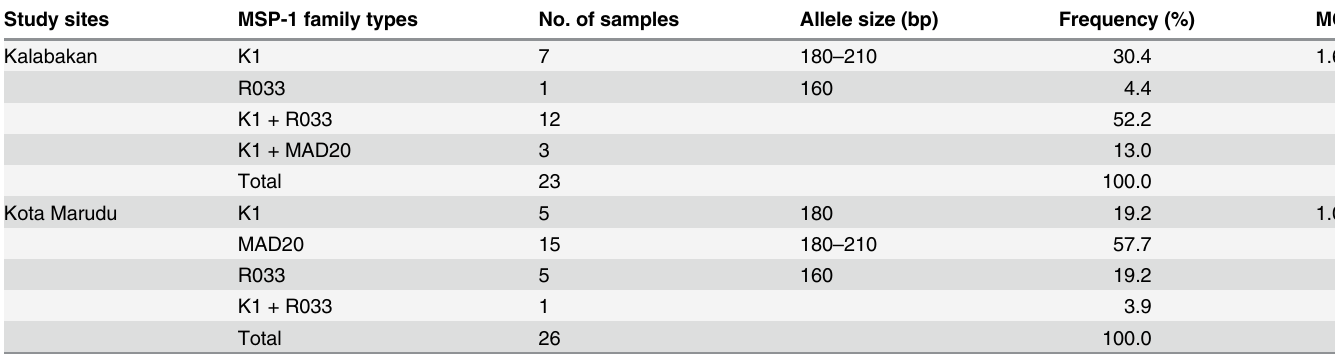
Table 3. Genotyping of P . falciparum MSP-1 polymorphic region block 2. Study